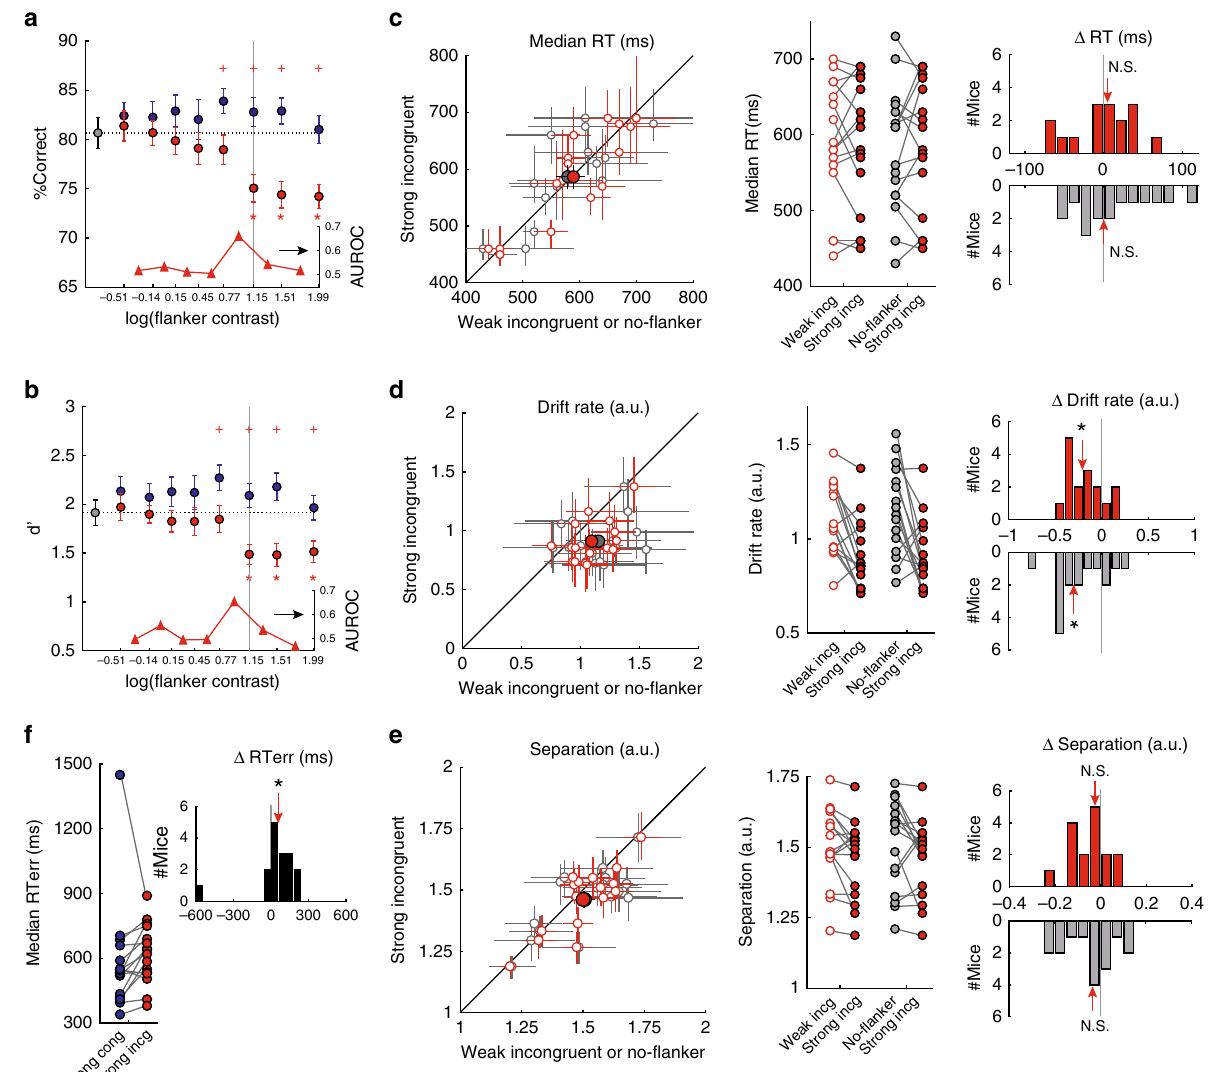
Fig. 4 Incongruent fl anker causes abrupt decrease in accuracy and d ’ , and reduction in rate of evidence accumulation, when stronger than target ( n = 16 mice). a Plots of response accuracy as a function of fl anker contrast (two-way ANOVA, effect of congruency, p < 0.001; effect of contrast, p = 0.021; interaction, p = 0.072). Gray vertical line: fi xed contrast of the target. Gray data: no fl anker; blue: congruent fl anker; red: incongruent fl anker. Data presented as group mean ± S.E.M. Red cross: p < 0.05; incongruent trials (red) were signi fi cantly different from congruent trials (blue) of that contrast level; red asterisk: p < 0.05; incongruent (red) trials were signi fi cantly different from no- fl anker trials. Insets below ( y -axis on right side): Ideal observer analysis quantifying area under the receiver operating characteristic (AUROC) between performance at successive pairs of contrasts in the incongruent condition, plotted at midpoint of each contrast pair. An abrupt increase in AUROC (sharp peak) was observed at fl anker contrast close to that of target. Going forward, fl anker contrast values 1 – 5 are referred to as ‘ weak ’ contrasts, and values 6 – 8, as “ strong ” contrasts. b Plots of perceptual sensitivity as a function of fl anker contrast (two-way ANOVA, effect of congruency, p < 0.001; effect of contrast, p = 0.109; interaction, p = 0.393). Conventions as in a . c – e Effect of strong incongruent fl anker on the median RTs ( c ), drift rate ( d ) and boundary separation ( e ), when compared with trials with weak incongruent fl ankers (red data), and trials with no fl anker (gray data). Left panel: scatter plots. Each open circle represents individual mouse: mean ± 95% con fi dence intervals shown. Filled circles represent group mean ± S.E.M. Middle panel: Comparison of value for each mouse between fl anker conditions. Right panel: distributions of the changes. Strong incongruent minus weak incongruent (red), or strong incongruent minus no- fl anker (gray) trials. Red arrow: median of the distribution; asterisk: p < 0.05, N.S. not statistically signi fi cant, two-sided signed-rank and HB tests. c Red data: p = 0.698; gray data: p = 0.698. d Red data: p = 0.005; gray data: p = 0.006. e Red data: p = 0.049; gray data: p = 0.088. f Median RT in error trials: comparison of strong incongruent fl anker trials versus strong congruent fl anker trials. Left panel: comparison for each mouse. Right panel: distribution of change in median RT ( p = 0.03, two-sided signed-rank tests). See also Supplementary Fig. 5. Source data are provided as a Source Data fi The above fi ndings also held true when the strong incongruent fl anker trials were compared with the no fl anker trials (Fig. 4c – e and Supplementary Fig. 5F, G; gray data), and, as expected, also when compared with the strong congruent fl anker trials (Supplementary Fig. 5H – L).